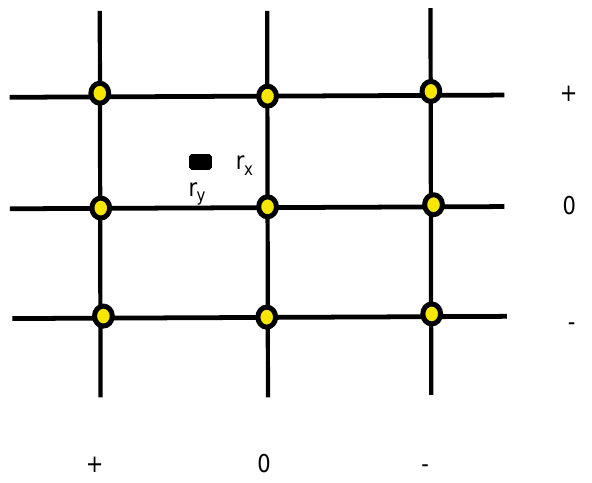
FIG. 1. (Color) Scheme of charge